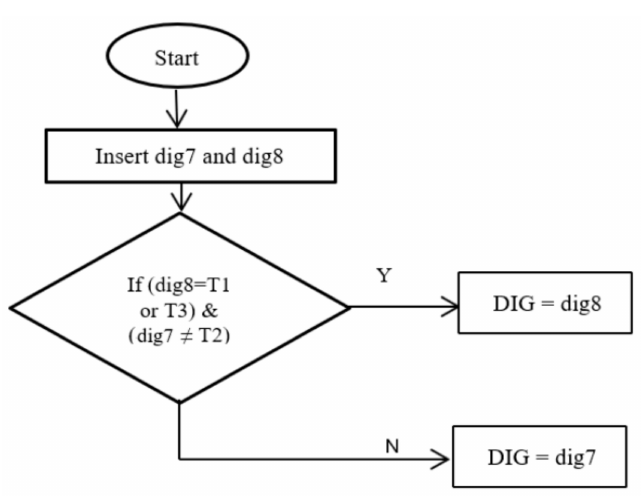
Figure 5. Flowchart procedure of technique no. 4.